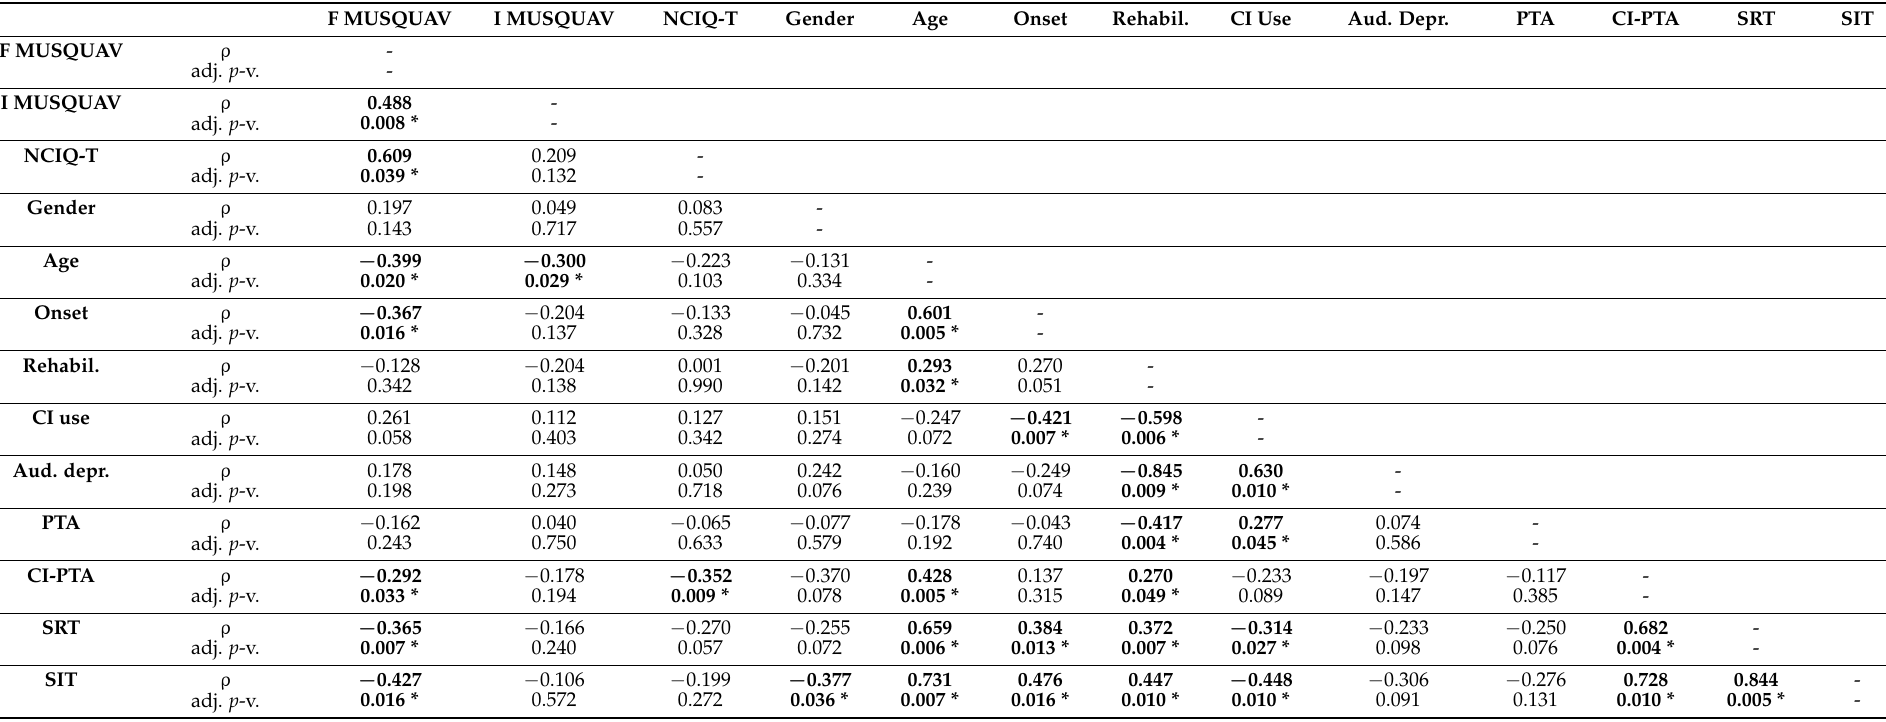
Table 2. Correlation matrix for PRO measures and both the clinical characteristics and audiological